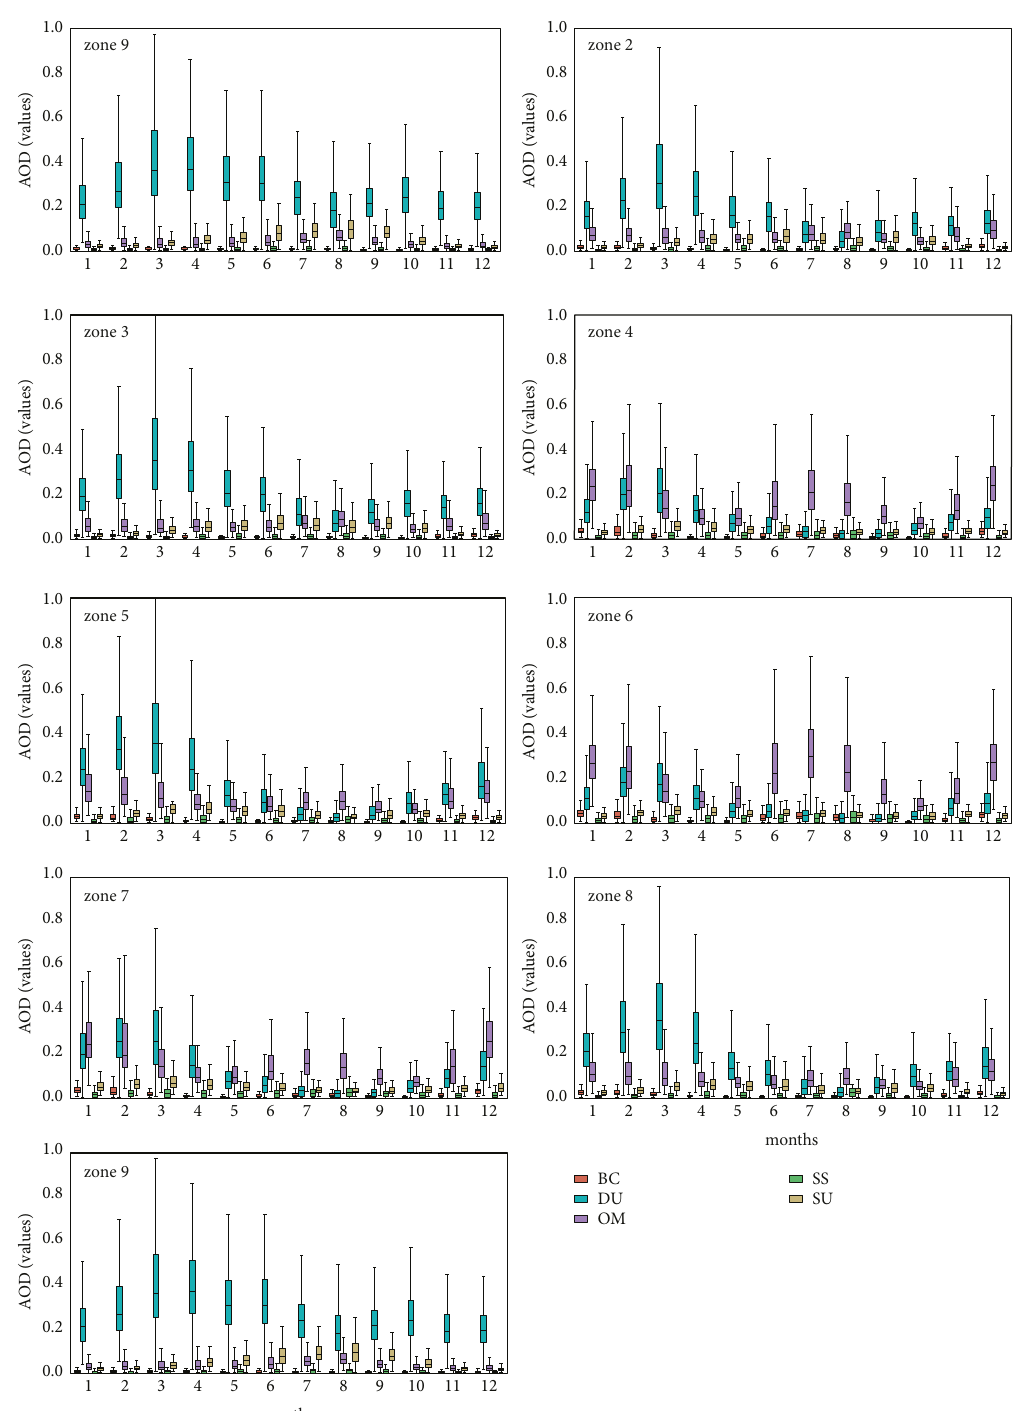
Figure 3: Intra-annual variability of aerosol optical